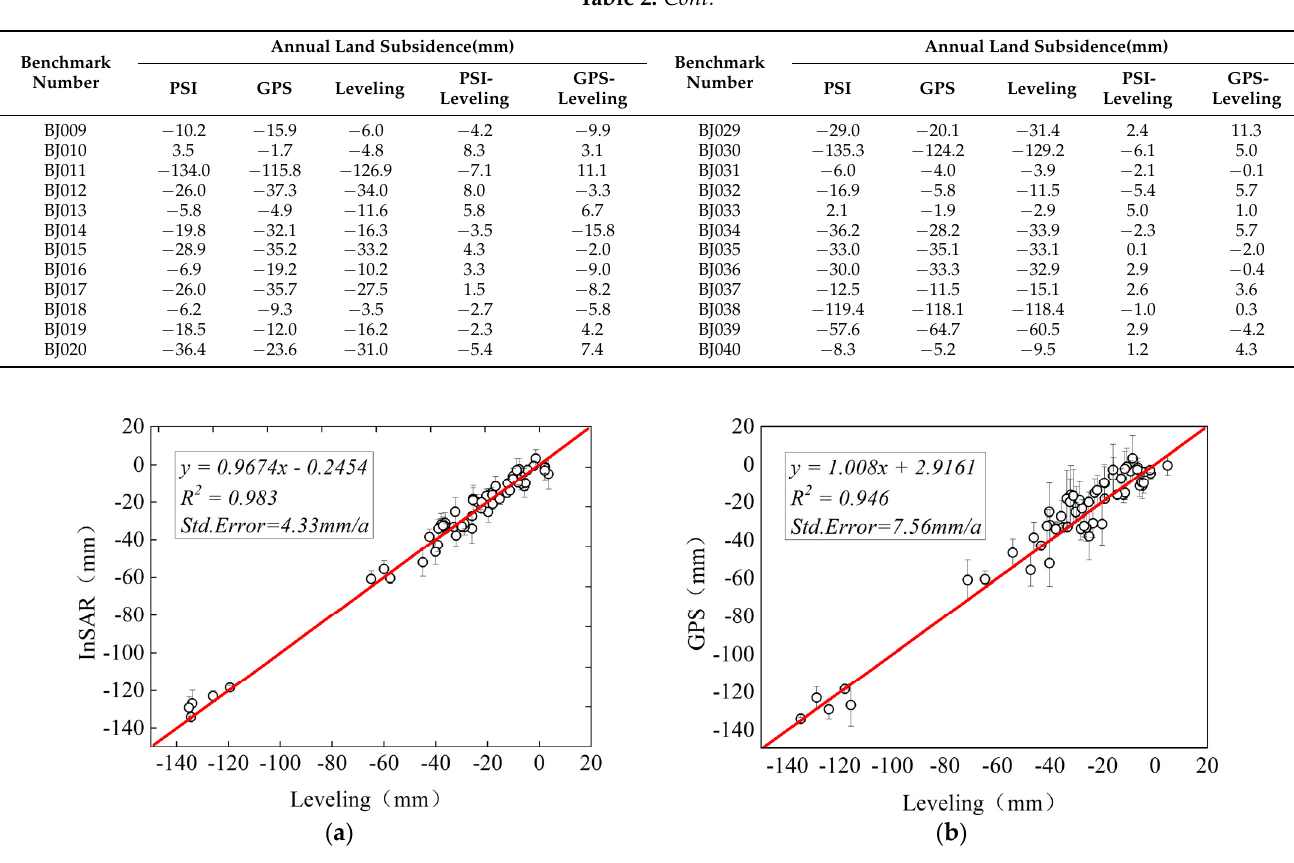
Figure 7. Comparison of time-series subsidence between PSI, GPS, and leveling. ( a ) Comparison of time-series subsidence between PSI and leveling. ( b ) Comparison of time-series subsidence between GPS and leveling.